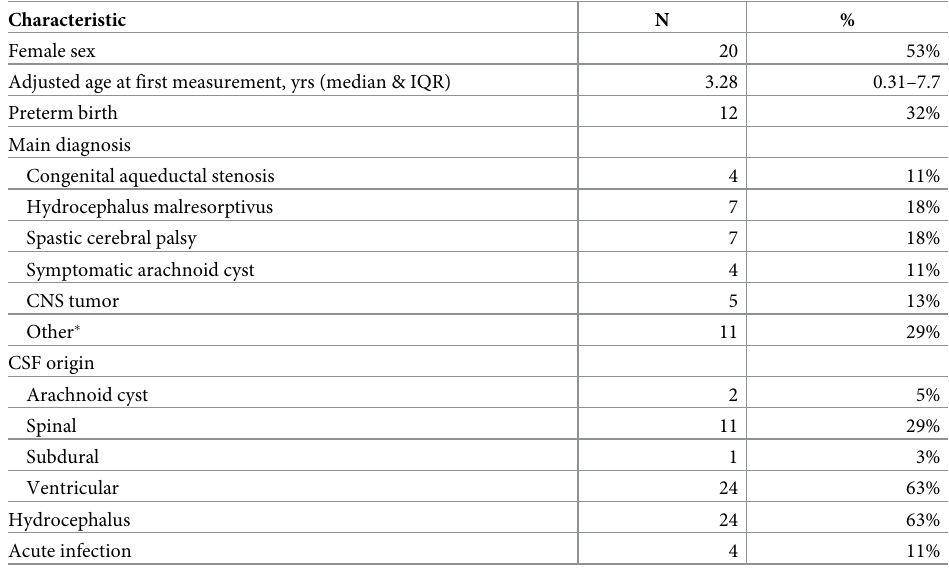
ml) or CSF samples (1:2 dilution) were incubated with the ruthenium-labelled m83 anti-DCX antibody (detection antibody, 0.16 μ g/ml) on a rotational shaker (600 rpm) for 4 hours at room temperature. After disposal of samples and 3 washes, 150 μ l/well of reading buffer (MSD read buffer T with surfactant) was added and the plate was immediately imaged on an MSD Sector Imager 6000. For the GPC2 assay, the same procedure was followed using biotinylated and ruthenium labelled anti-GPC2 antibodies (capture antibody: mAB2/32 1 μ g/ml, Roche; detection antibody AF2304, R&D systems, 0.5 μ g/ml) and recombinant GPC2 (R&D Systems 2304-GP, range between 4.11 to 3’000 pg/ml). The mean limit of detection (LOD) for each assay was 5.8 and 0.05 pg/ml for DCX and GPC2, respectively.